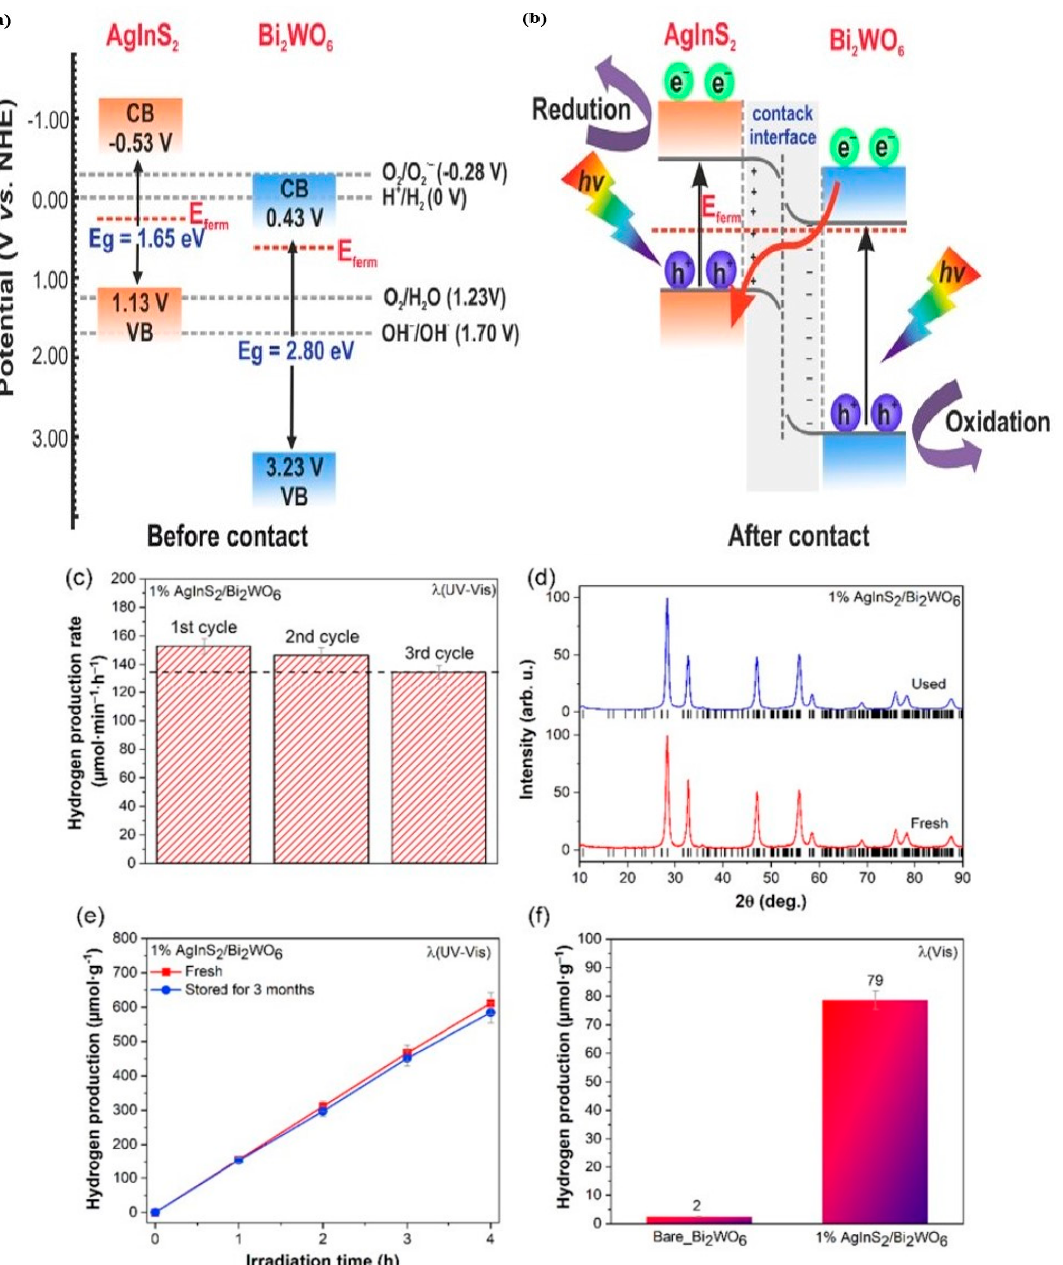
Figure 5. ( a , b ) Schematics for band gap match and electron–hole pair separation in AgInS 2 QDs/Bi 2 WO 6 composite (before/after contact), ( c ) Reusability, ( d ) XRD pattern of 1 wt% AgInS 2 - modified Bi 2 WO 6 before/after three cycles of PC-H 2 generation, ( e ) Stability during prolonged storage of 1 wt% AgInS 2 -modified Bi 2 WO 6 , and ( f ) Visible light irradiation in presence of AgInS 2 /Bi 2 WO 6 . [Reprinted with permission from reference [109]. Copyright 2020, Elsevier].